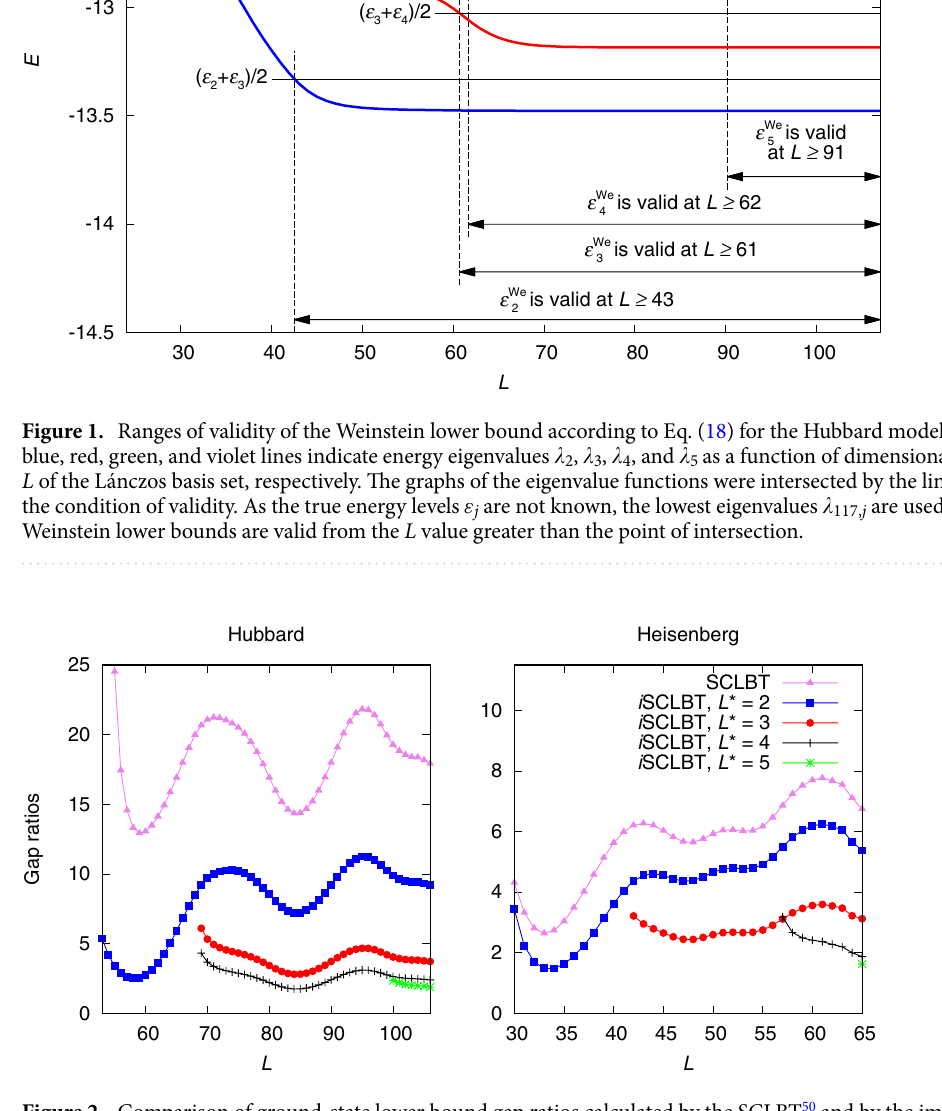
Figure 2. Comparison of ground-state lower bound gap ratios calculated by the SCLBT 50 and by the improved version ( i SCLBT) presented in this paper for the Hubbard (left panel) and Heisenberg (right panel) models. The violet line indicates the previous lower bound methodology and the blue, red, gray, and green lines indicate the i SCLBT calculations at L ∗ = 2 , L ∗ = 3 , L ∗ = 4 , and L ∗ = 5 , respectively, for both